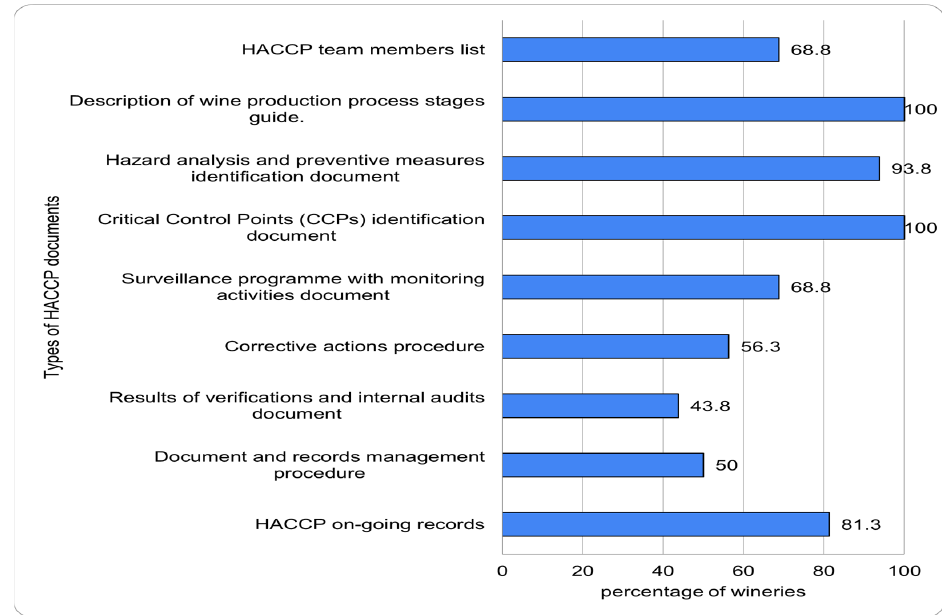
Figure 4. The percentage of total wineries that have included each type of document in their HACCP system.